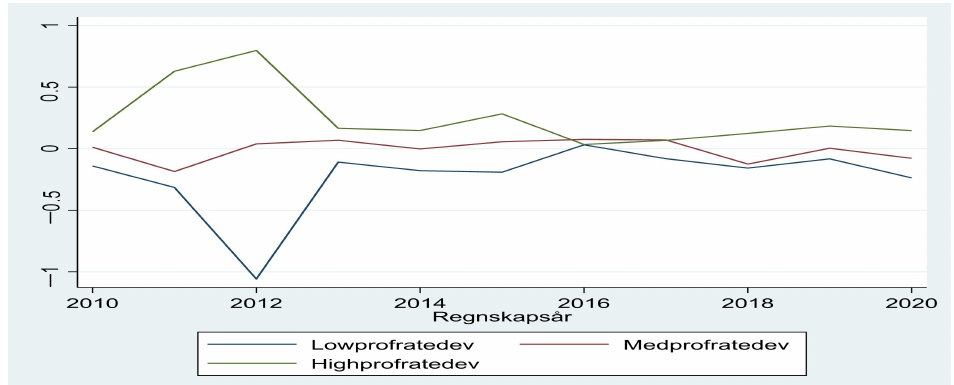
Figure 4. The development of the gap in profits follows in large part the pattern outlined by Mueller (cf. Figure 3). Companies that perform differently from the average company converge to the norm during the period.